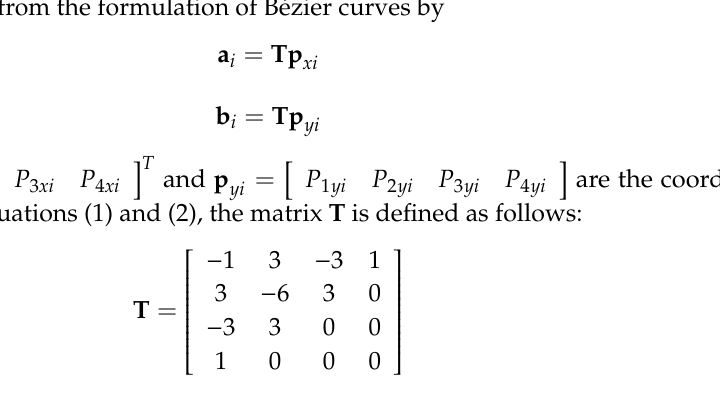
and . Each fourth of the